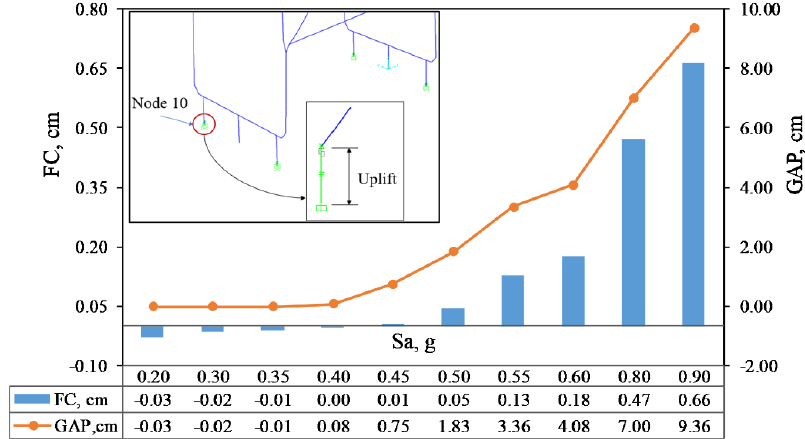
Figure 8. Vertical displacement for the landside leg (Node 10).